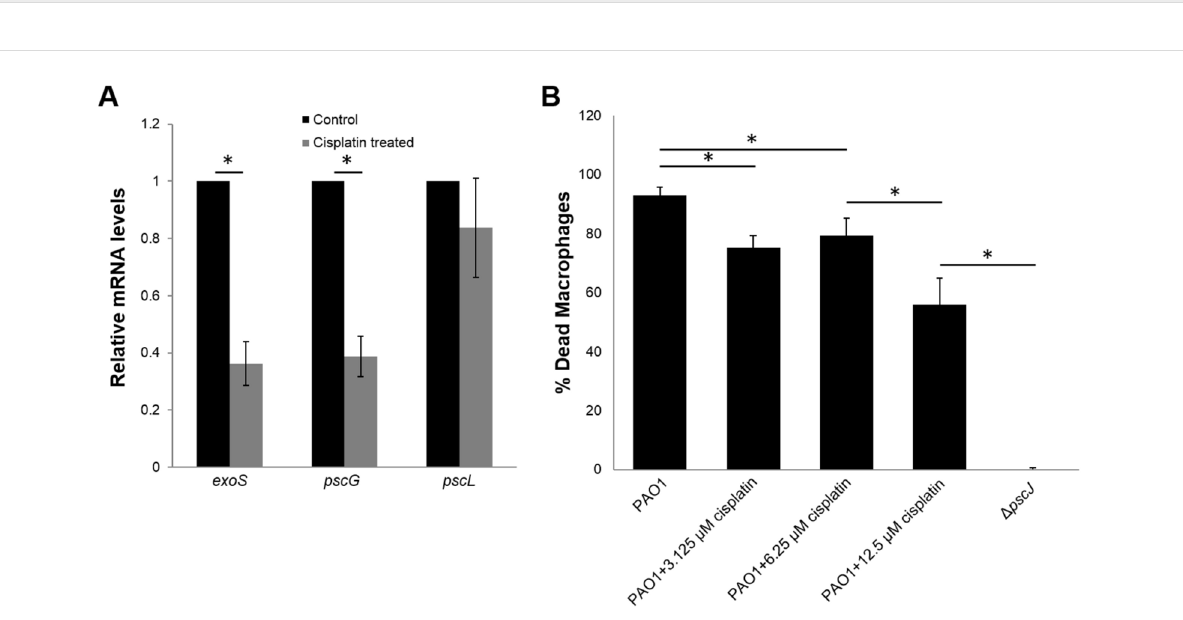
Figure 5: Cisplatin treatment represses T3SS associated virulence. (A) Cisplatin treatment downregulated the expression of T3SS gene revealed by qRT-PCR analysis. Means and s.d. from triplicate experiments are shown. Student’s t-test was performed for testing differences between groups. * P ≤ 0.05. (B) Cisplatin treatment reduced cytotoxicity of P. aeruginosa PAO1 against mouse macrophage cells. Means and s.d. from triplicate experi- ments are shown. Student’s t-test was performed for testing differences between groups. * P ≤